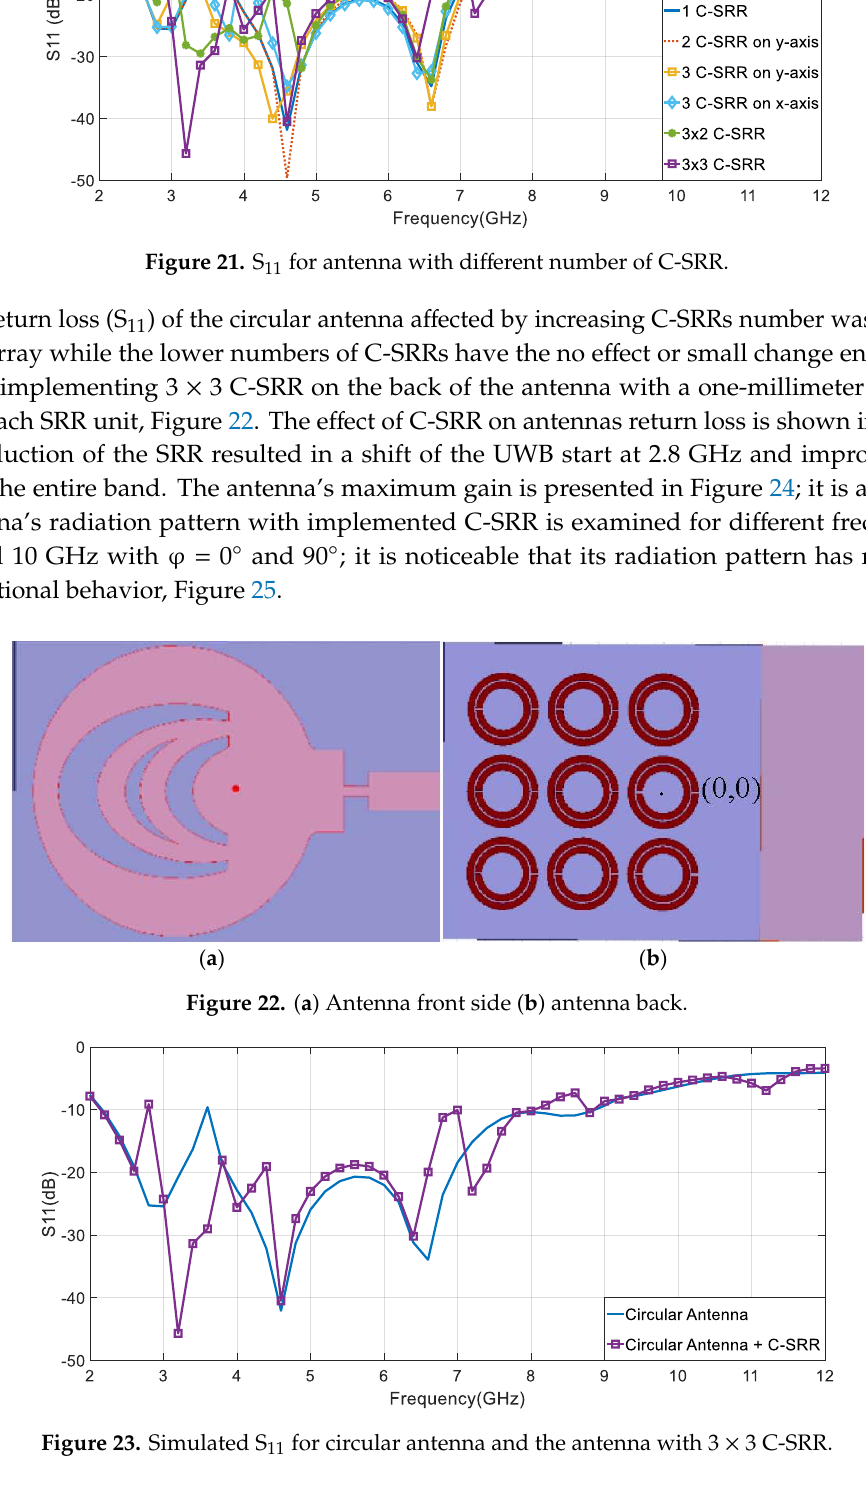
Table 4. Results of C-SRR implementations with the antenna.